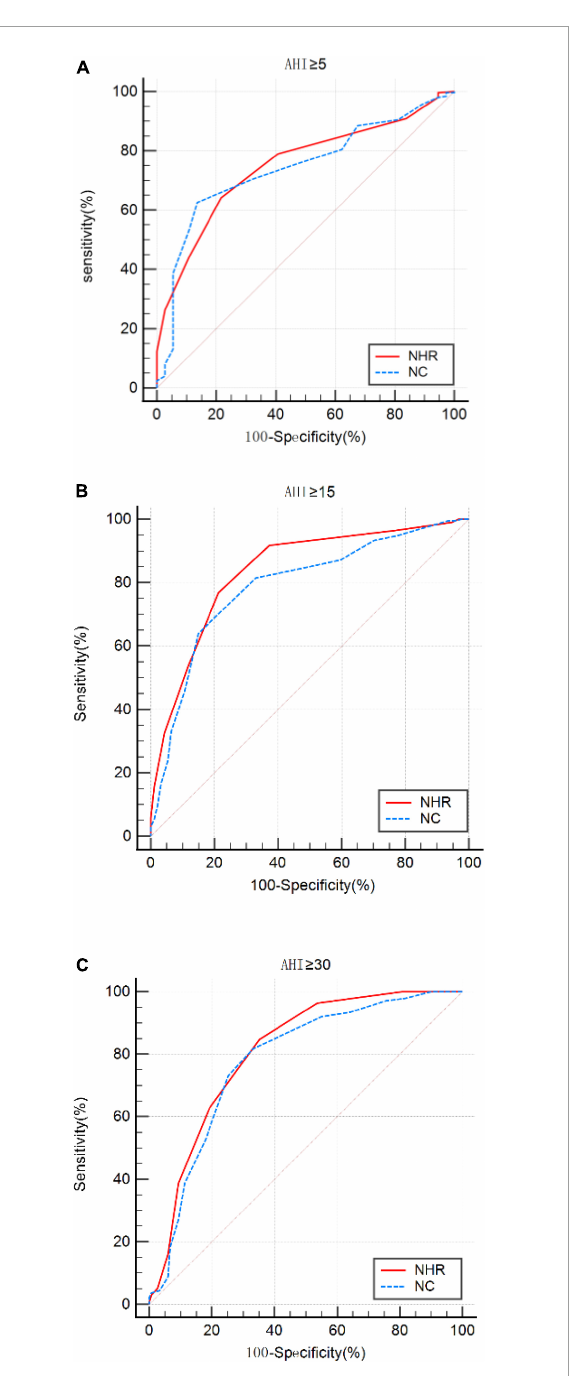
FIGURE2 ROC curves for neck-to-height ratio (NHR) and neck circumference (NC) at apnea-hypopnea index (AHI) cut-off points (A) ≥ 5, (B) 15, and (C) 30 times/h.